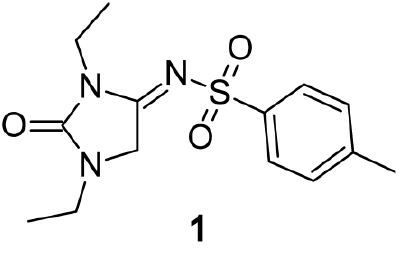
Figure 1. Chemical structure of N -[1,3-diethyl-2-oxoimidazolidin-4-ylidene]-4-methylbenzenesulfonamide ( 1 ). The reaction between 1,3-dialkyl-4,5-dihydroxyimidazolidin-2-ones and the